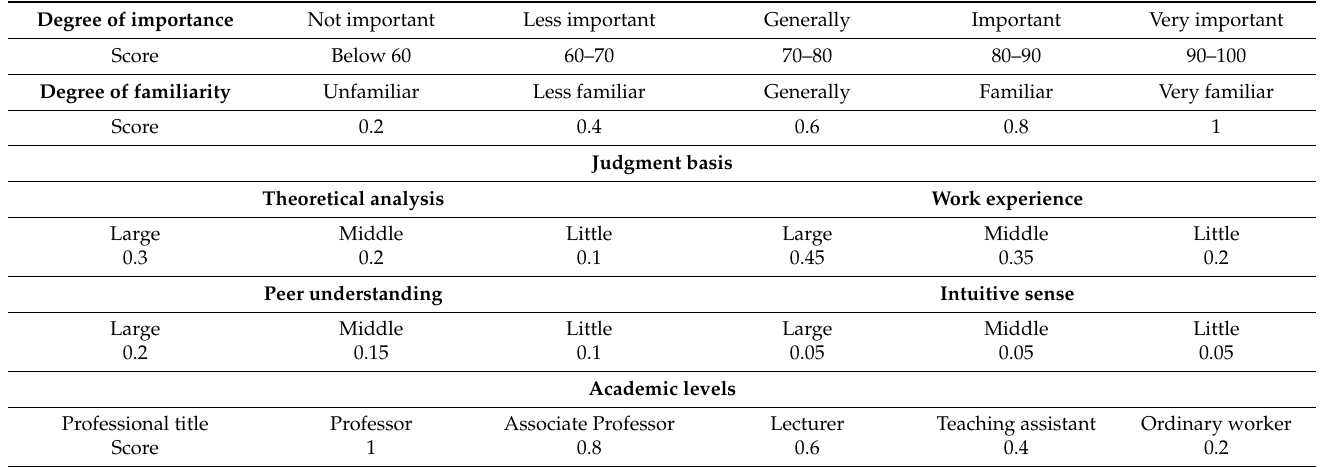
Table 2. Expert scoring criteria.